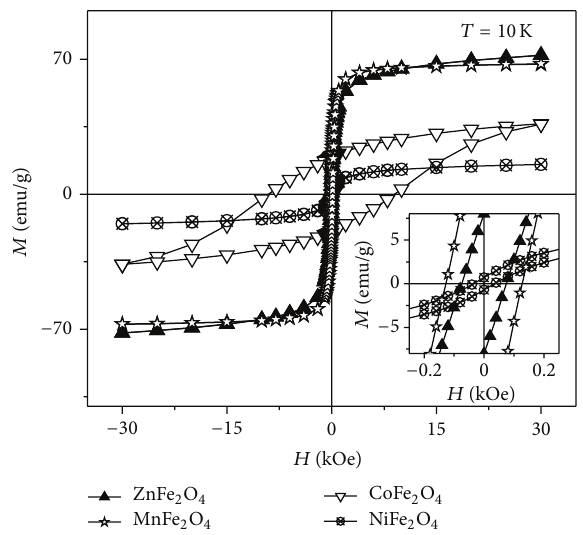
Figure 4: The magnetization 𝑀 versus magnetic field 𝐻 depen- dences for the NPs of zinc, manganese, cobalt, and nickel spinel ferrites.Themagnetizationcurveswereobtainedat10 K.Insetshows the same dependences in the region of low